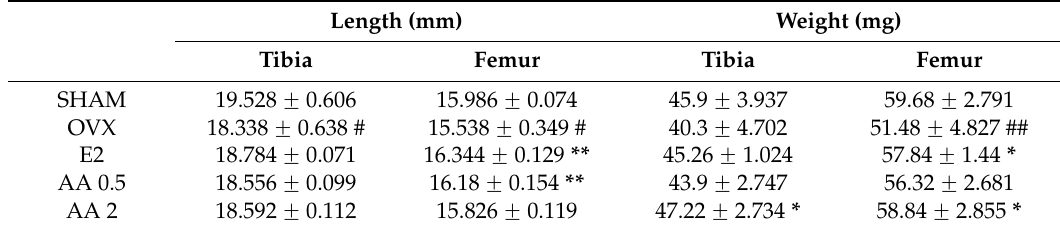
Table 1. Effect on AA (alisol A-24 acetate) on weight and length in bone of OVX